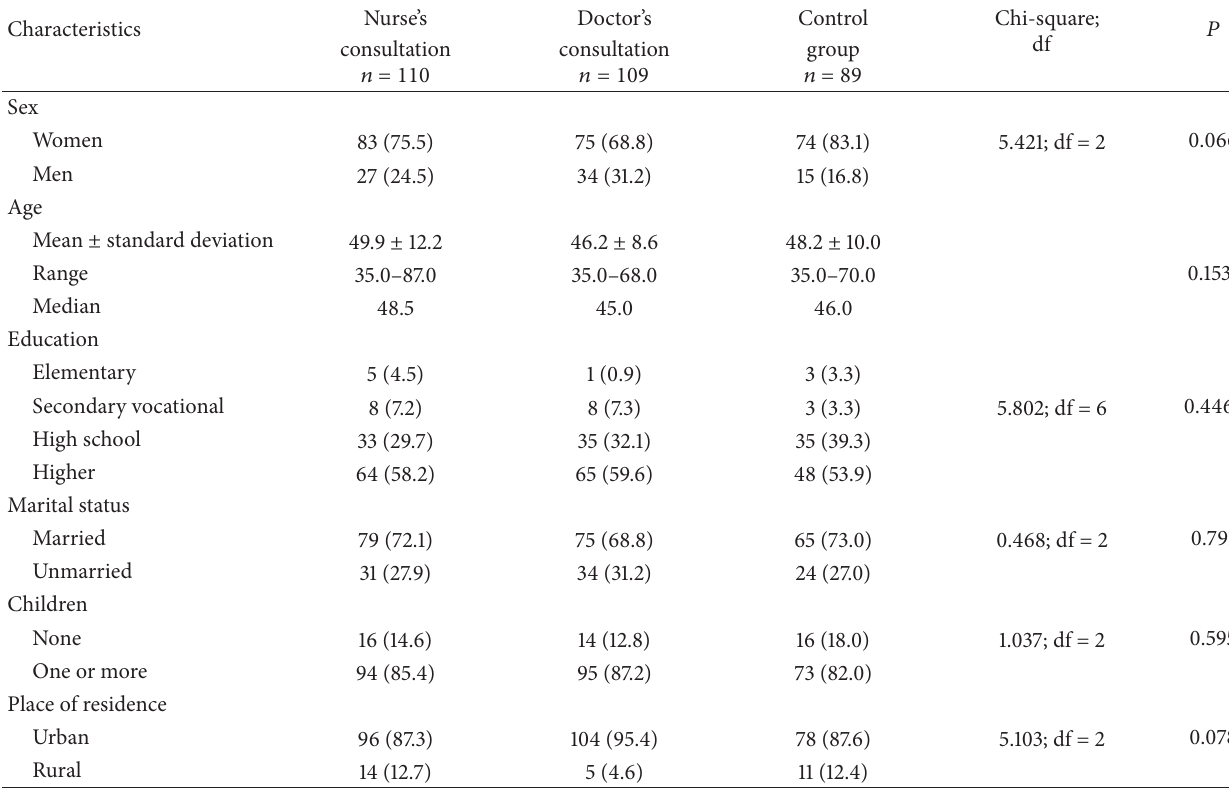
Table 1: Demographics of study